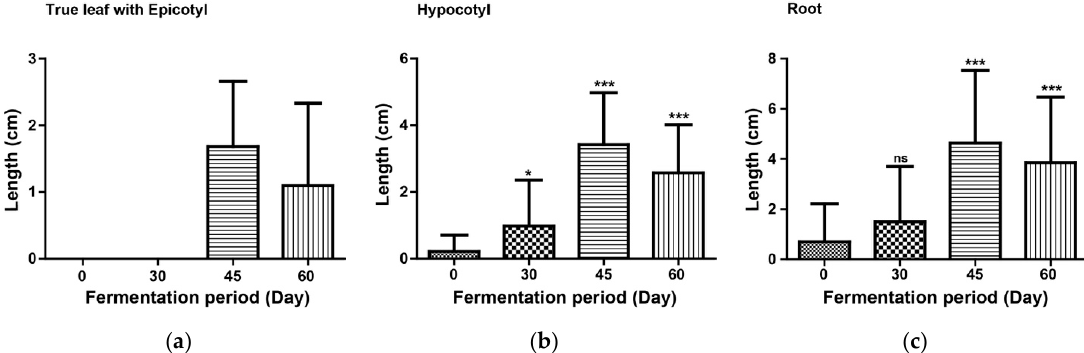
Figure 3. Effect of the fermentation period [unfermented sawdust (0), 30-day fermented sawdust (30), 45-day fermented oak tree sawdust (45), and 60-day fermented oak tree sawdust (60)] on seedling length. (a): True leaf with epicotyl; (b): Hypocotyl; (c): Root. Each fermentation period was statistically compared with 0 day. The asterisks indicate significant difference (ns p > 0.05, * p < 0.05, and *** p < 0.001).